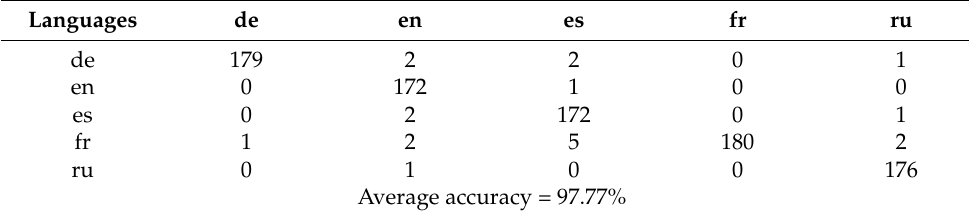
Table 6. Confusion matrix for common voice